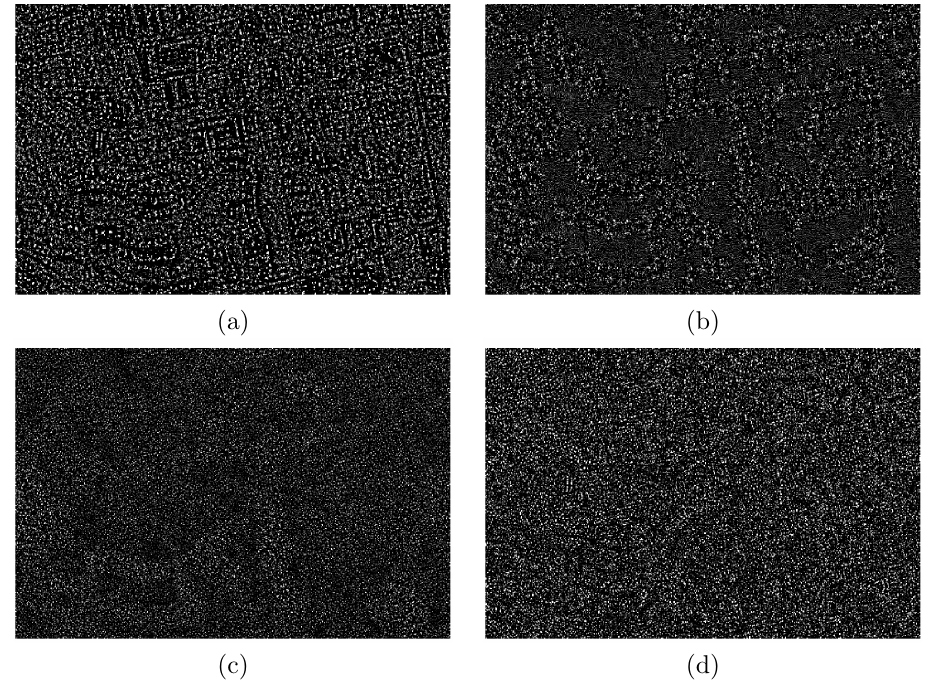
Figure 14. Houston test case. Zoom of the selected area ratio images obtained after proceeding with the filtering algorithms: ( a ) Kuan, ( b ) PPB-it, ( c ) FANS, and ( d ) EWF. The overlapping of the PDF of the ratio of the restored output images in comparison with the one related to the expected speckle in amplitude format is sketched in Figure 15.